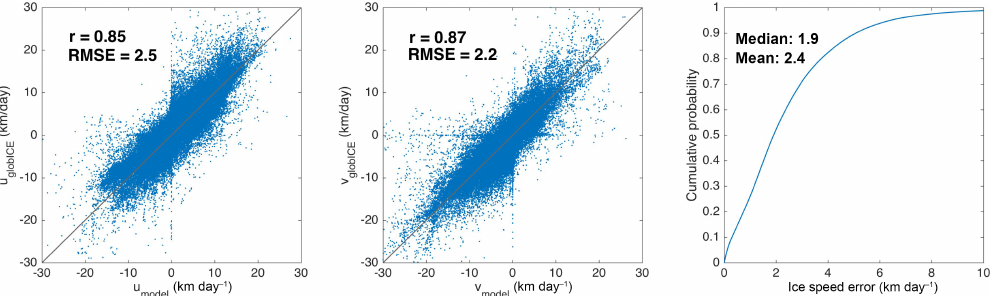
Figure 4. Scatter plots for the two components of all the simulated and observed drift vectors between 31 October 2007 and 28 April 2008 (left and middle panels). Cumulative distribution of all the velocity errors (right panel).